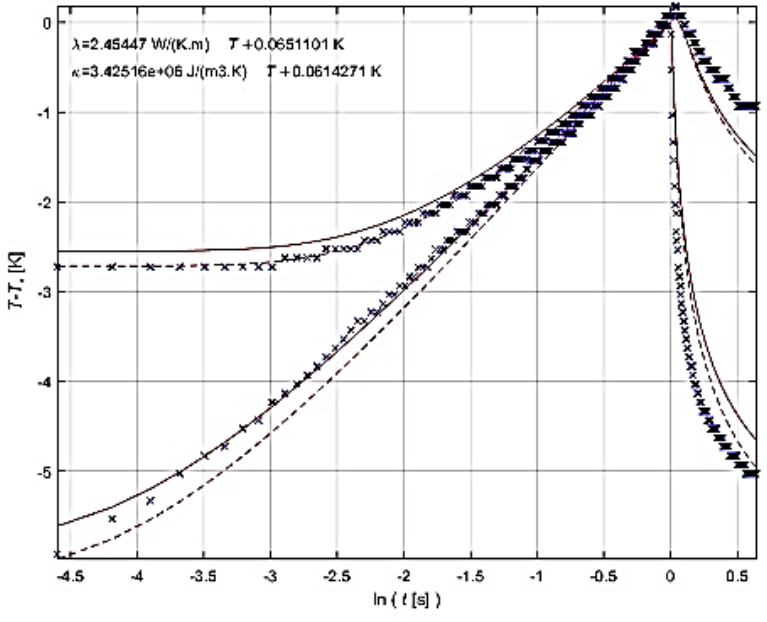
Figure 3. The iterative convergence process of λ and κ